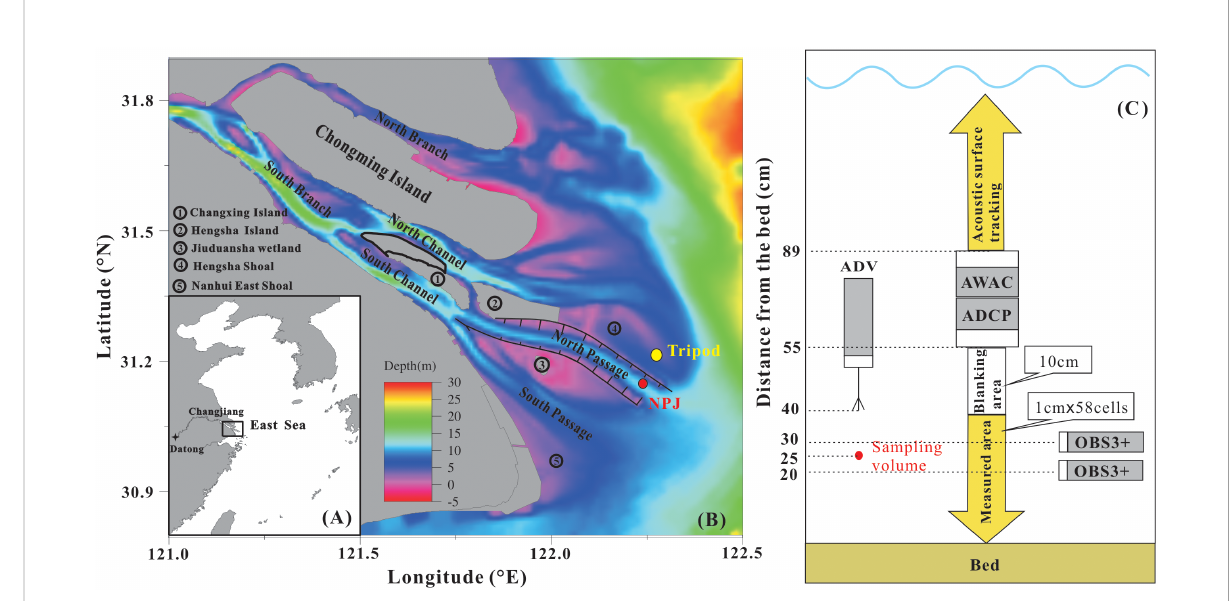
FIGURE 1 (A) Location of Yangtze Estuary. (B) Map of the Yangtze Estuary showing the observation sites by means of tripod. (C) Schematic representation of instrument deployment and location with respect to the seabed. The AWAC was used to obtain the wave parameters. the ADCP and the OBS3+ were used to measure velocity pro fi les and turbidity signal respectively. The ADV was deployed for the high-frequency sampling of velocity data at 8 Hz as well as the bed level